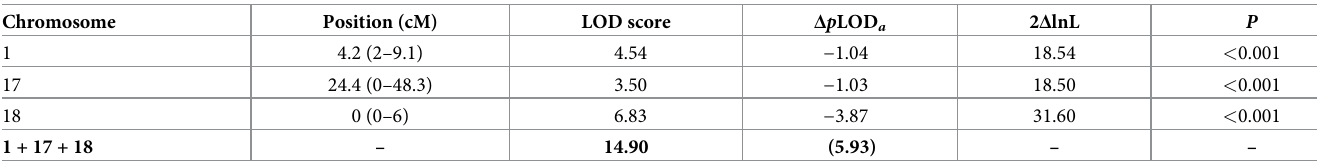
Position in cM (1.5-LOD interval), change in penalized LOD score compared to the full (best supported) model incorporating all three putative QTLs (in bold), 2 Δ lnL and P values compare the full model to reduced models in which individual QTLs were eliminated, and n = 139. Abbreviations : LOD, log odds ratio; Δ p LOD , penalized LOD score; QTL, quantitative trait a